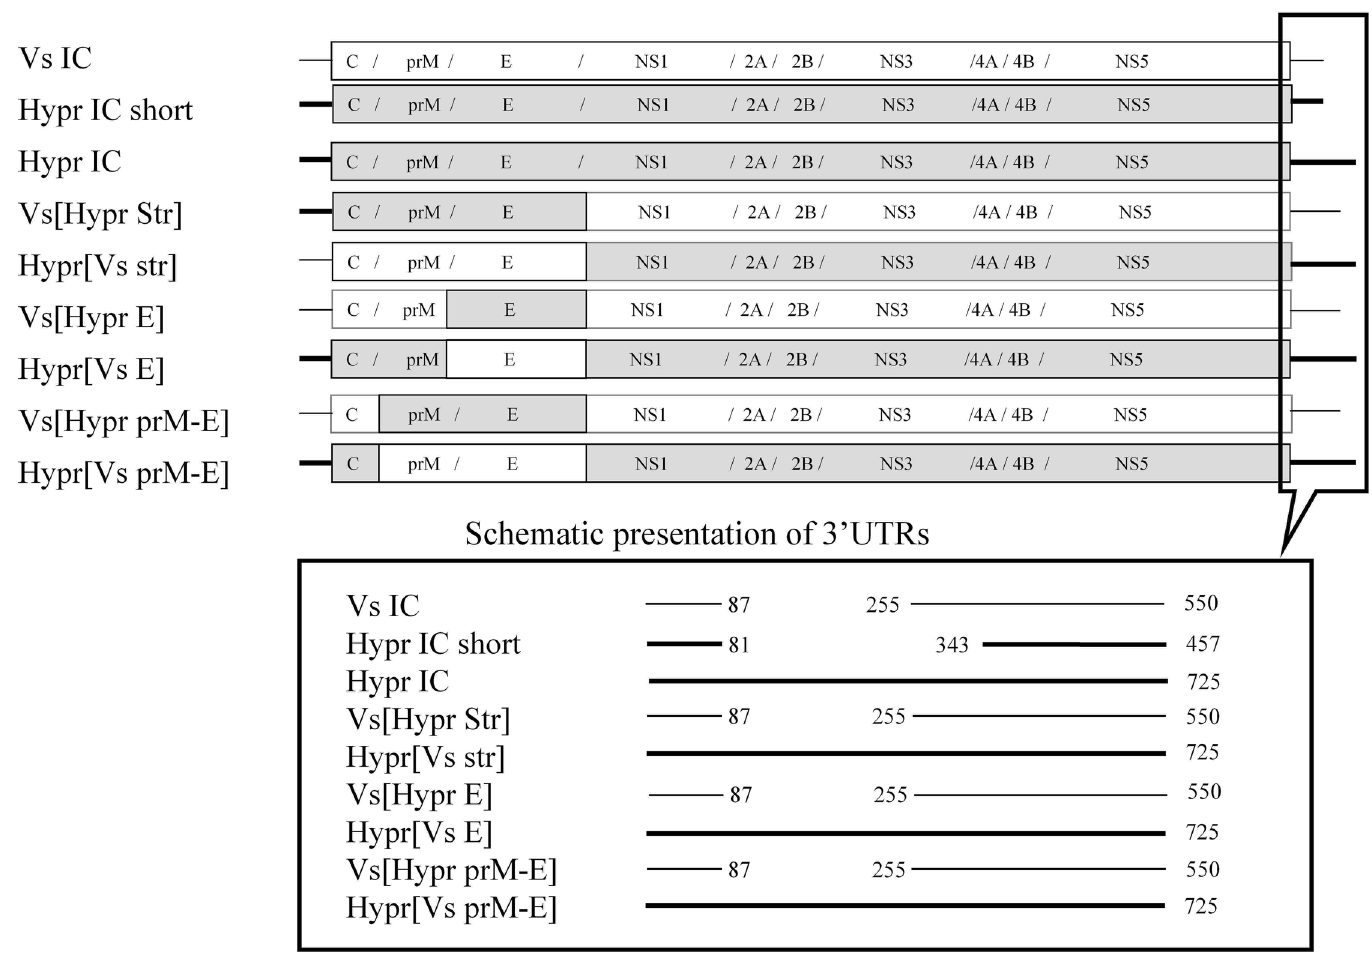
Fig 2. Vs and Hypr chimaeric viruses. A) The polyproteins, with individual proteins of Hypr virus (grey bars) and Vs virus (white bars) are flanked with 3`UTR (thick and thin lines for Hypr and Vs respectively). B) Schematic representation of the 3`UTRs., Numbers specify nucleotide positions in 3 ’ UTRs following the stop codon. Internal deletions present in the Hypr and Vs genomes are identified by the numbers corresponding to those of the Hypr-long 3 ’ UTR. Intermediate plasmids, constructed to recover Hypr, Vs and chimaeric Hypr/Vs infectious virus, are presented in S1